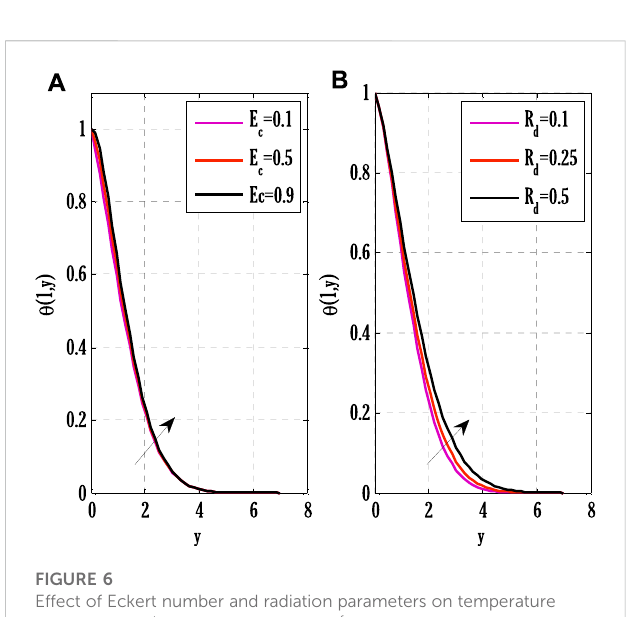
FIGURE 8 Effect of Schmidt number and reaction rate parameter on concentration pro fi le using N t (cid:2) 150 , N y (cid:2) 45 , L (cid:2) 7 , t f (cid:2) 1 , E c (cid:2) 0 . 5 , R d (cid:2) 0 . 25 , P r (cid:2) 1 , S c (cid:2) 1 , R d (cid:2) 0 . 25 , M (cid:2) 0 . 5 , β (cid:2) 3 , F r (cid:2) 1 . 5 , μ 1